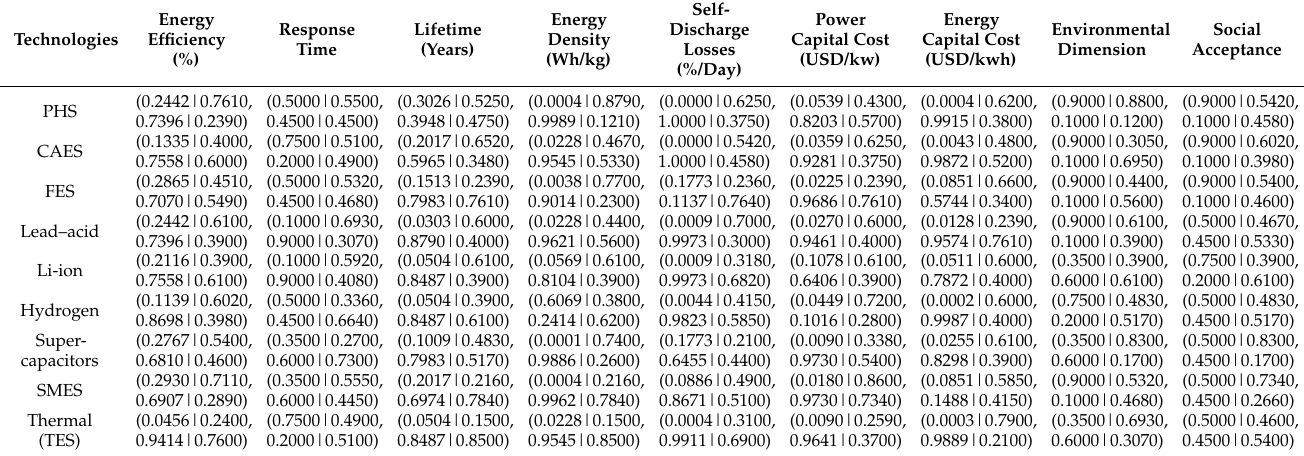
Table A12. Initial decision matrix of Expert 7.